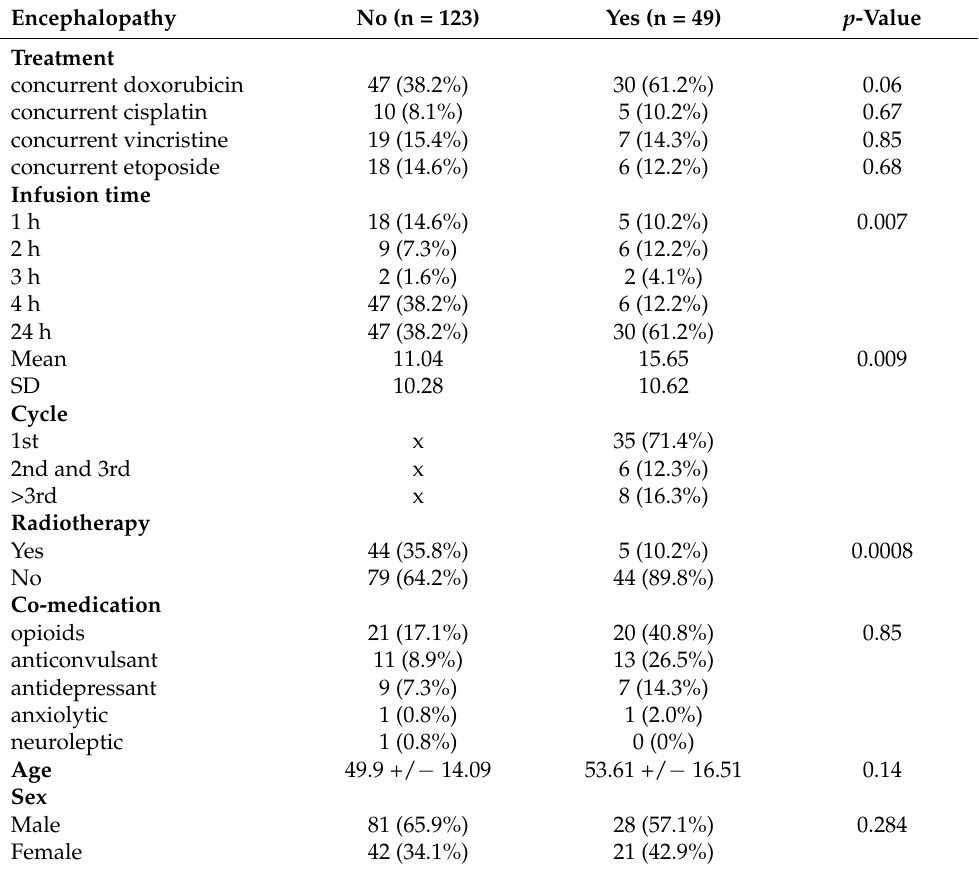
Figure 1. Clinical characteristics in STS patients with IIN. ( a ) Histopathological subtypes in the sarcoma study cohort. ( b ) Number of sarcoma patients with or without IIN with regard to UICC classification, tumor grading ( c ), tumor stage ( d ), lymph node invasion, ( e ) and the occurrence of metastasis ( f ). UICC = Union for International Cancer Control; IIN = ifosfamide-induced neurotoxicity. Table 2. Treatment characteristics.